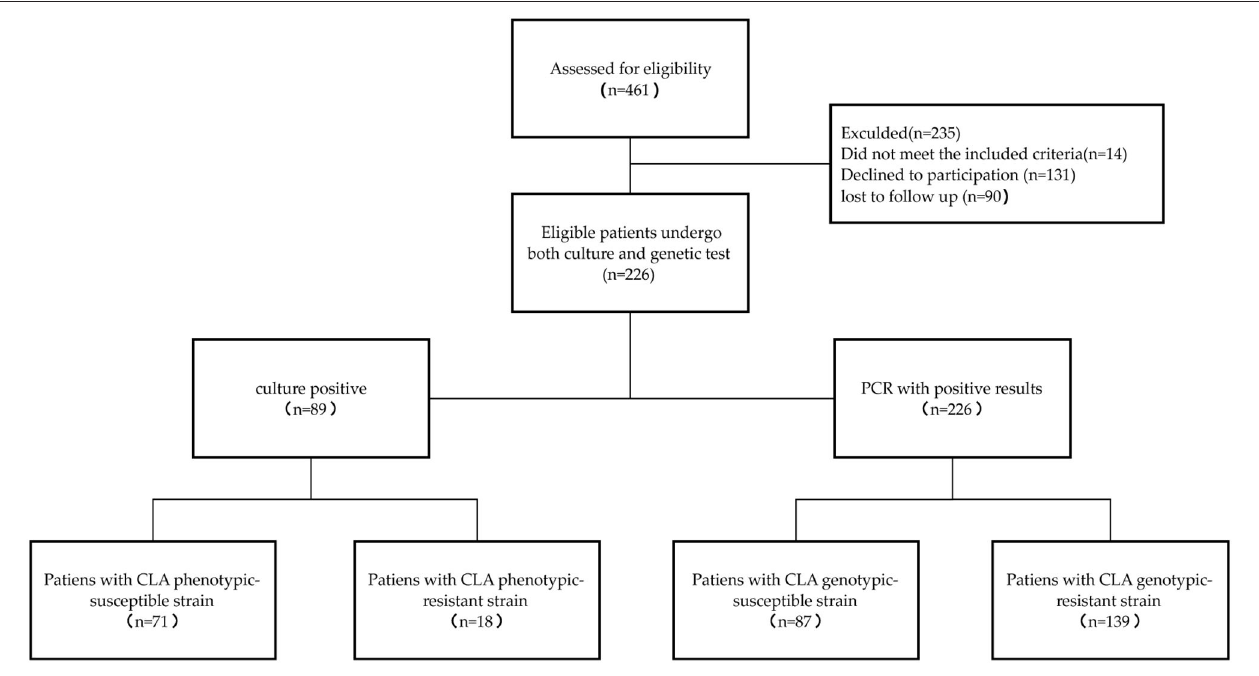
FIGURE 1 | Flow chart of participant